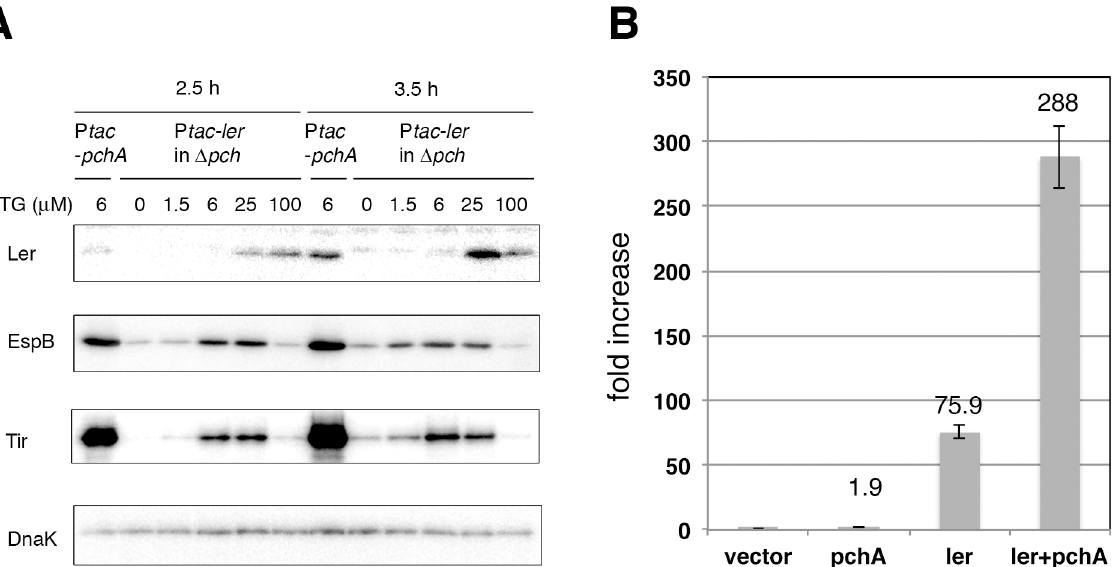
Fig 2. Activation of LEE genes in the presence or absence of Pch. A. Dose effect of Ler on LEE gene expression. The EHEC pch mutant ( Δ pchA Δ pchB Δ pchC ) harboring the P tac-ler operon fusion plasmid pTB101- ler was grown in DMEM containing various amounts of IPTG for 2.5 or 3.5 h, after starting its growth in fresh medium. The production of Ler, EspB and Tir was monitored by immunoblotting. As a reference, the production of these proteins in the pch mutant harboring P tac-pchA plasmid pTB101- pchA , grown in DMEM containing 6 μ M IPTG, is shown. The DnaK level was the quantitative control. B. Activation of LEE2 promoter activity by Pch and Ler. W3110 harboring pLux-P LEE2 and pTB101 (vector) or P tac-pchA plasmid pTB101- pchA (pchA) or P tac-ler plasmid pTB101- ler (ler) or P tac-ler plasmid pTB101- ler and P lac-pchA plasmid pSU- pchA (ler+pchA) were grown in LB containing 6 μ M IPTG at 37°. Luciferase activity was measured when the OD 600 reached approximately 1.0, and the luciferase value was normalized according to the OD 600 . The activity is presented as a fold increase compared to the activity of the vector